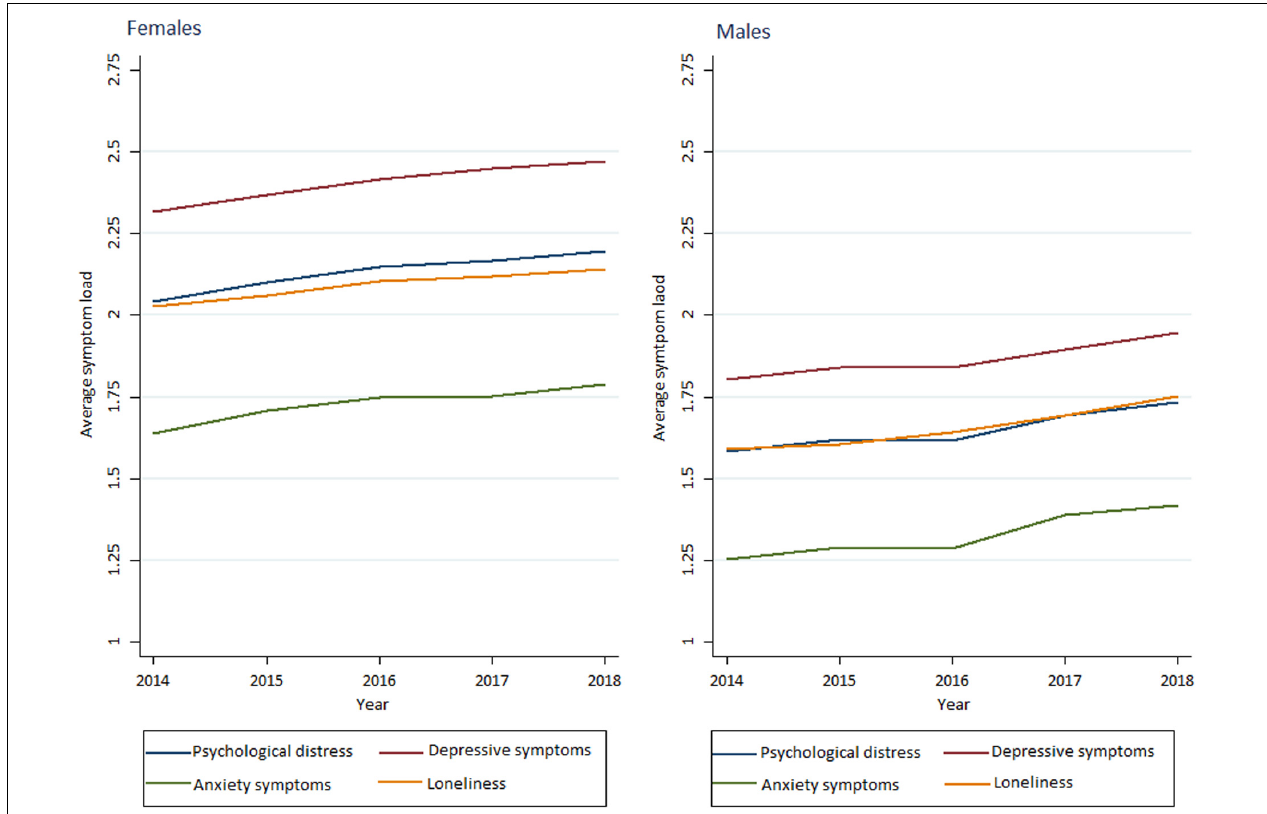
FIGURE 1 | Trends in average mental health symptom loads among girls and boys across the five cross-sectional surveys of secondary school students (ungdata survey).